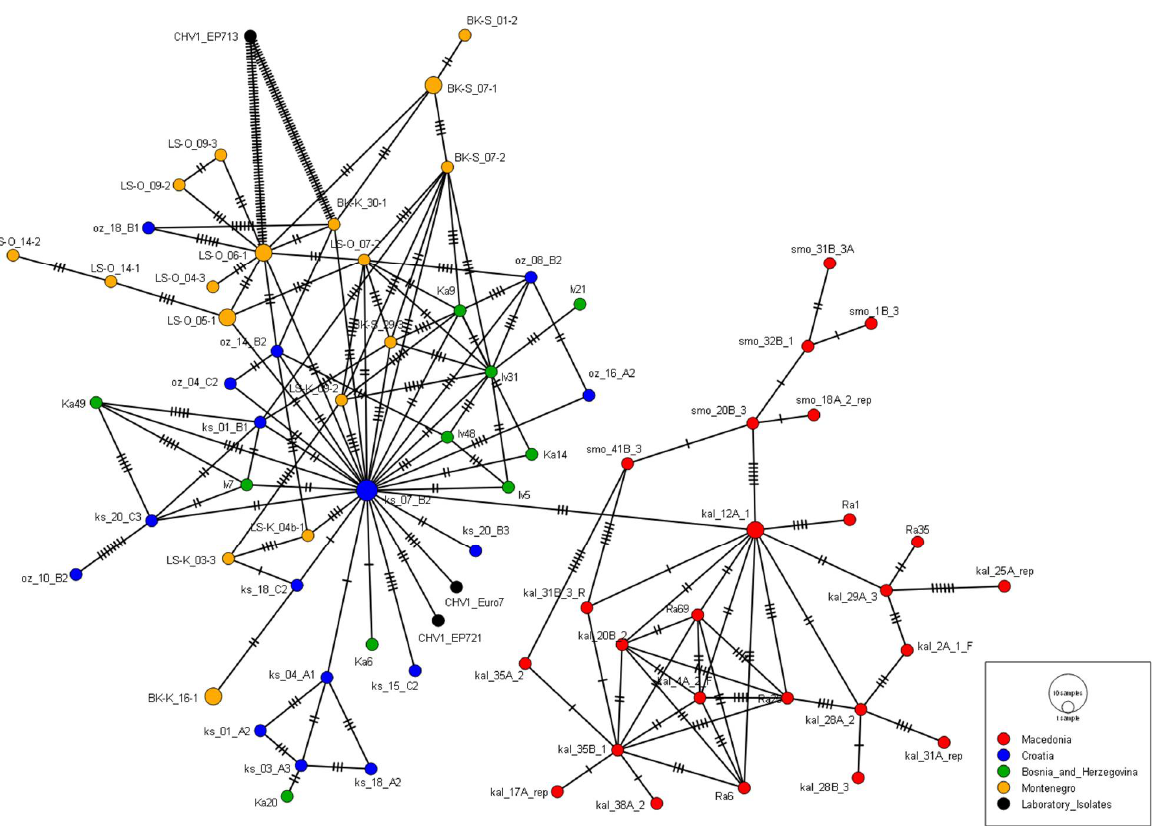
Figure 3. Haplotype network with 561 nt long Cryphonectria hypovirus 1 sequences from the ORF-A region of the genome. Circle sizes correspond to the number of isolates sharing the same consensus sequence. Isolates from Montenegro are represented with orange, from Croatia with blue, from Bosnia and Herzegovina with green and from North Macedonia with red. Reference laboratory strains EP713, EP721 and Euro7 are represented with black. The bars indicate the number of single-nucleotide mutations separating two sequences.